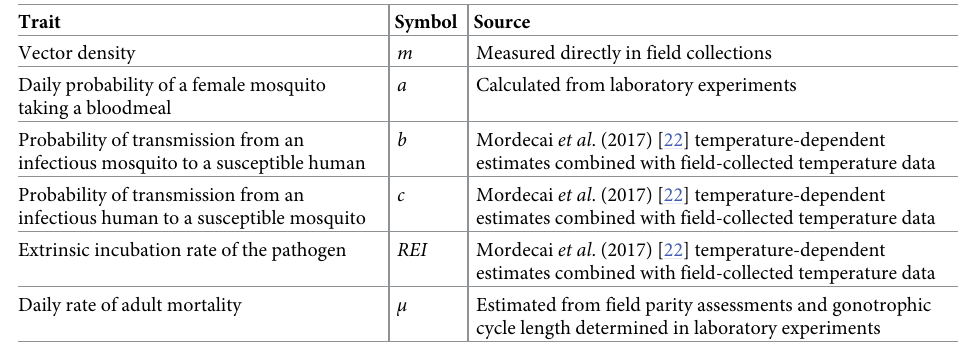
Table 1. Traits and data sources for vectorial capacity parameters